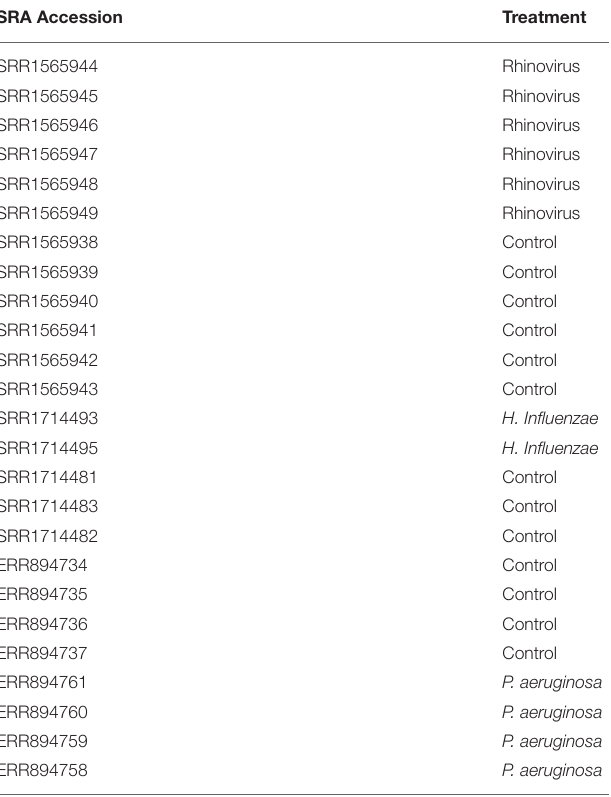
TABLE 1 | Indicated RNA-seq datasets corresponding to bronchial epithelial cells infected by various pathogens were downloaded from the NCBI